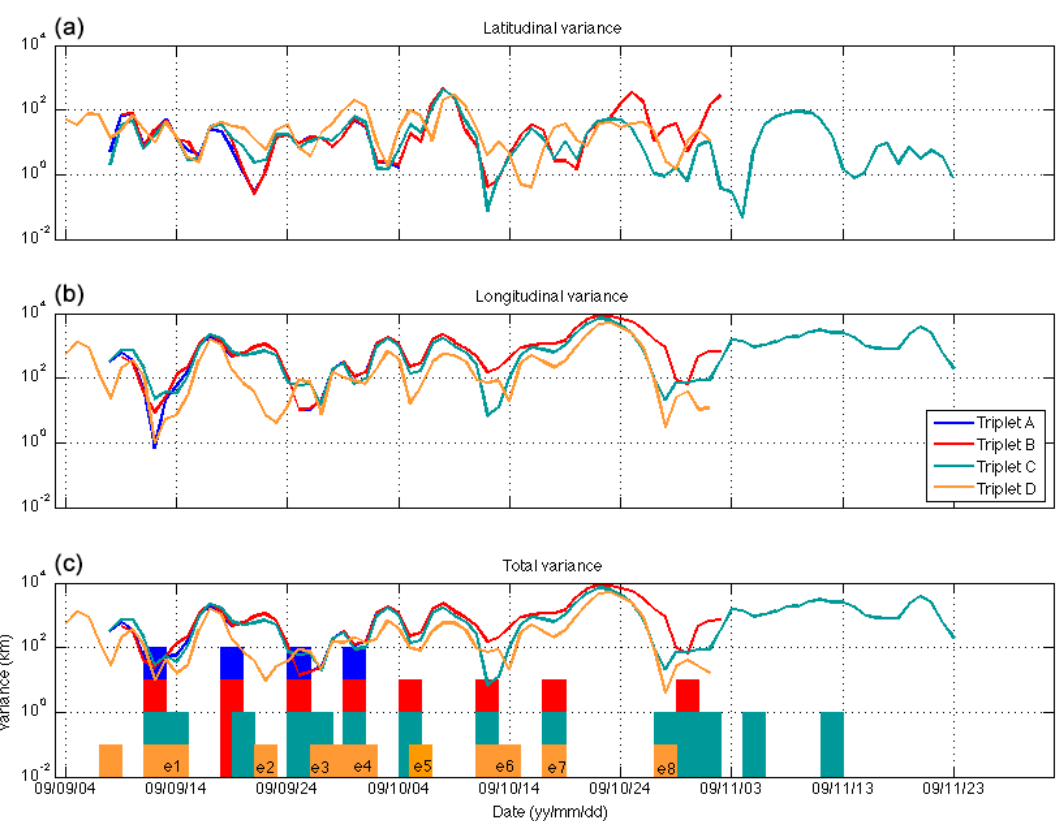
Figure 2. Directional changes in centroid trajectories of triplets A to D, defined as minima in the time series for the total variances of the 3-day running mean triplet centroid positions. The upper, middle, and lower panels (a–c) depict latitudinal, longitudinal, and total variance, respectively. The bars in the bottom panel (c) depict the triplet events associated with minima in the total variance. Enhanced latitudinal variance is observed for triplet D relative to triplet A in late September/early October. By contrast longitudinal variance decreases with increasing distance from the coastline, evidenced in lower values for triplet D relative to triplet A. Comparison with mean SLP in the vicinity of the triplets shows correspondence between SLP and drift variance maxima prior to 8 October; minima occur between SLP and variance